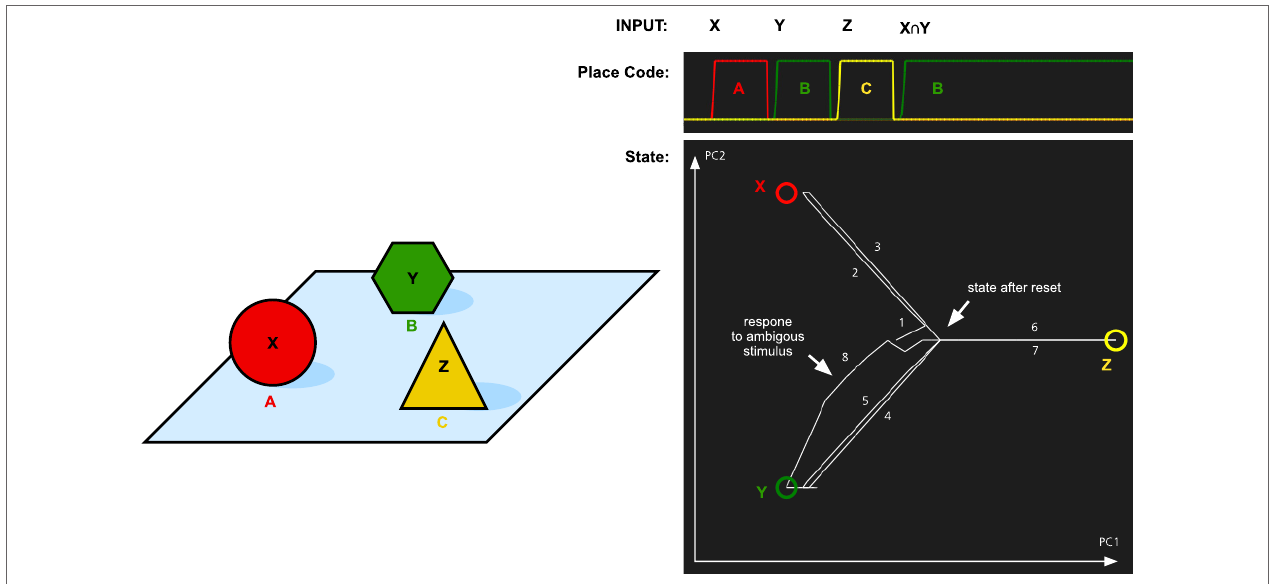
FigUre 4 | Simulation of place recall. Left: A scene with three objects X, Y, and Z at three places A, B, and C. The memory system was initially trained on these three objects. Right: The graph at the top shows the activation of the localization network when each object is used as input. Finally, an input pattern that consists of the overlapping parts of X and Y is used as input. This stimulus is equally similar to X and Y and thus ambiguous. The result is that the most recently attended place with an object similar to the input is recalled, that is, B. At the same time, the activity pattern in the identification system restores the complete pattern for Y. The graph at the bottom left shows transitions through the memory space. The image shows the memory state over time plotted in a two-dimensional space generated by the first two principal components (PC1 and PC2) of the attractor states. The circles represent the memories of X, Y, and Z, and the line shows how the memory state transitions between the memories as a response to the different input and the numbers show the order of the different transitions. The center of the image where all lines meet corresponds to the empty memory state after